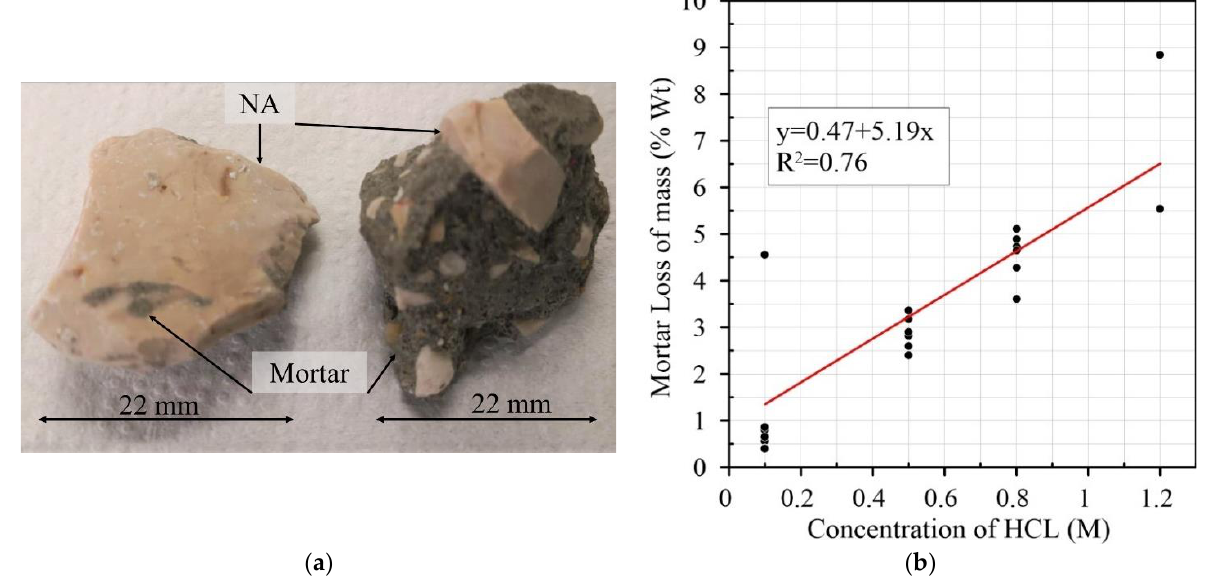
Figure 6. ( a ) CA particle size with different mortar contents; ( b ) relationship between concentration of HCl (M) and mortar loss of mass (% Wt) [6,8 – 11,13 – 15]. Table 3. Pearson correlation for RCA treated